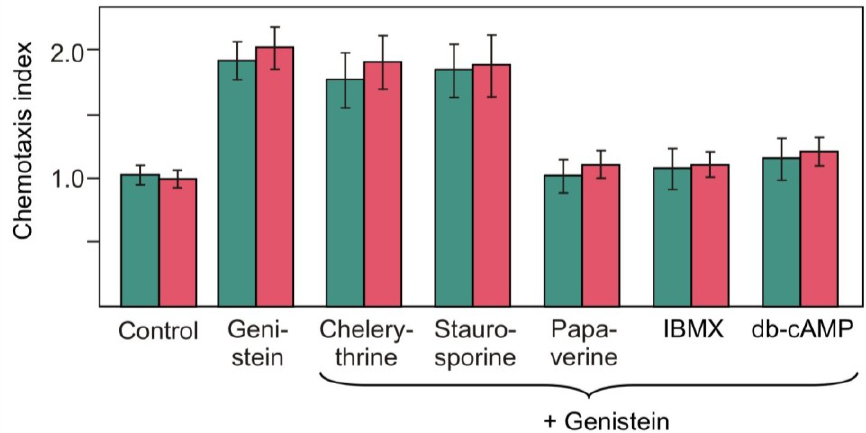
Figure 7. Treatment of pregametes of strain RNAi20 in the light with combinations of pharmacological compounds that either activate or inhibit the loss of chemotaxis in pregametes towards nitrite (■) and nitrate (■). Compounds were added to pregametes 10 min prior to start of illumination at the fluence rates of 60 µmol m −2 s −1 for 2 h. The genistein concentration was 200 μM. The concentrations used for other compounds were the same as those given in the legend of Figure 5. Non-treated cells were used as